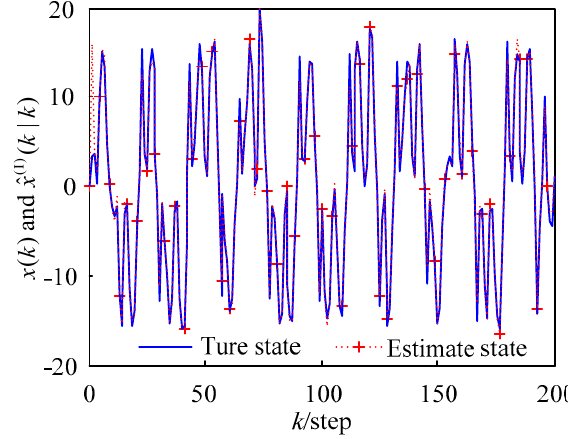
Figure 3. Curves of the true values and estimates using the WMF-PF2.